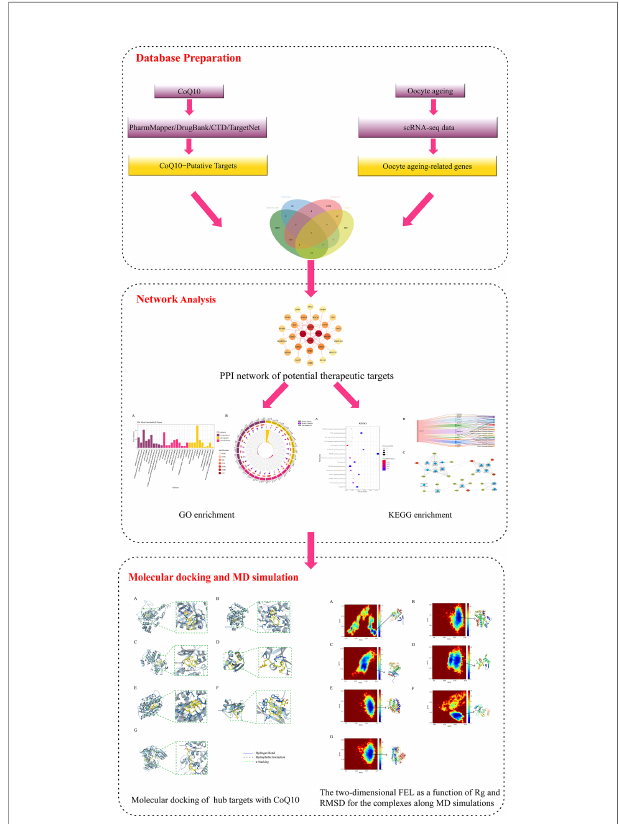
FIGURE 1 | Work fl ow diagram of this